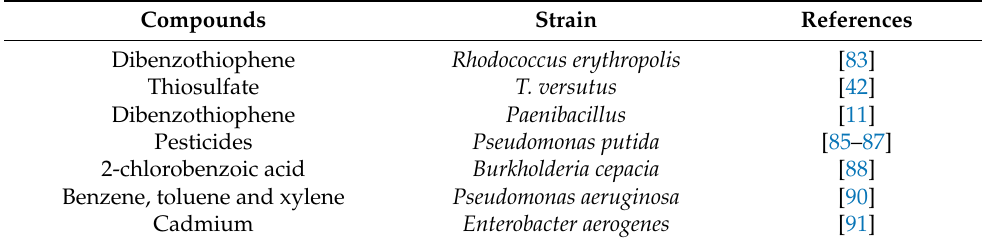
Table 4. The applications of VHb in